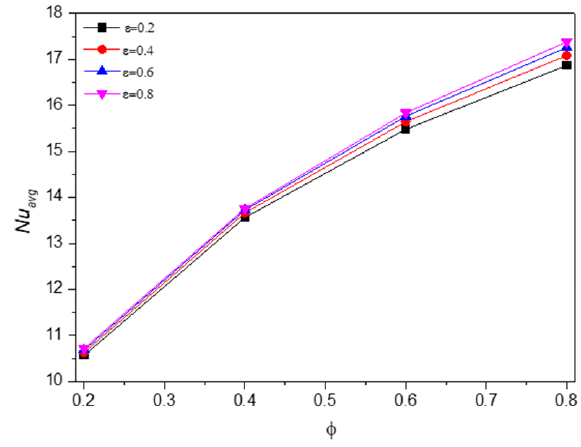
Figure 15. Total entropy as a function of solid volume fraction (𝜙) at various values of porosity 𝜀 (cid:3043) . Ra = 10 6 , Ha = 0, and Da = 0.01.